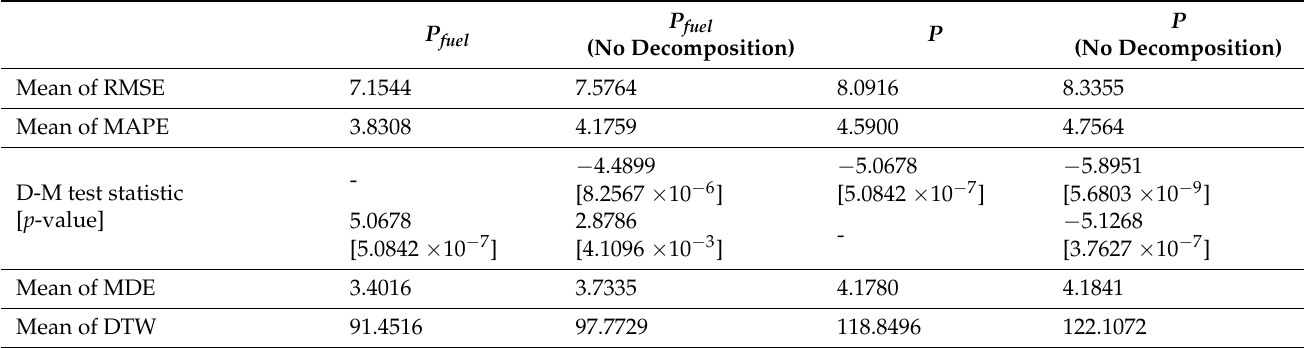
Table 4. The comparison of the forecasting on the 1 st case